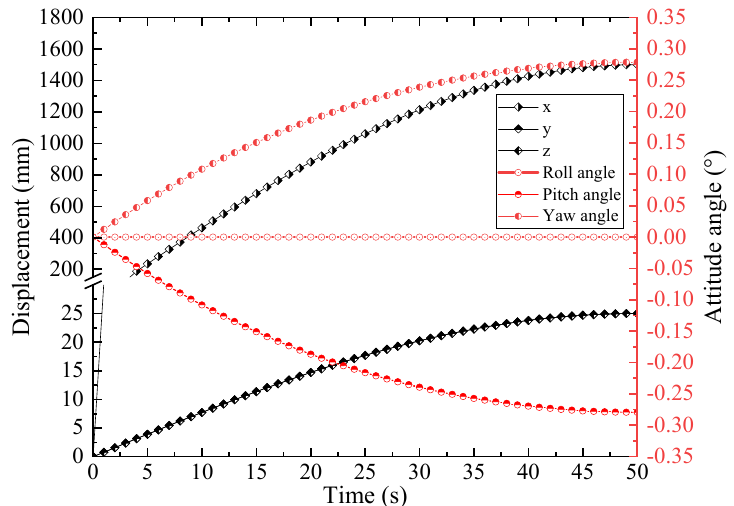
Figure 6. Target shield pose parameters variation with time.